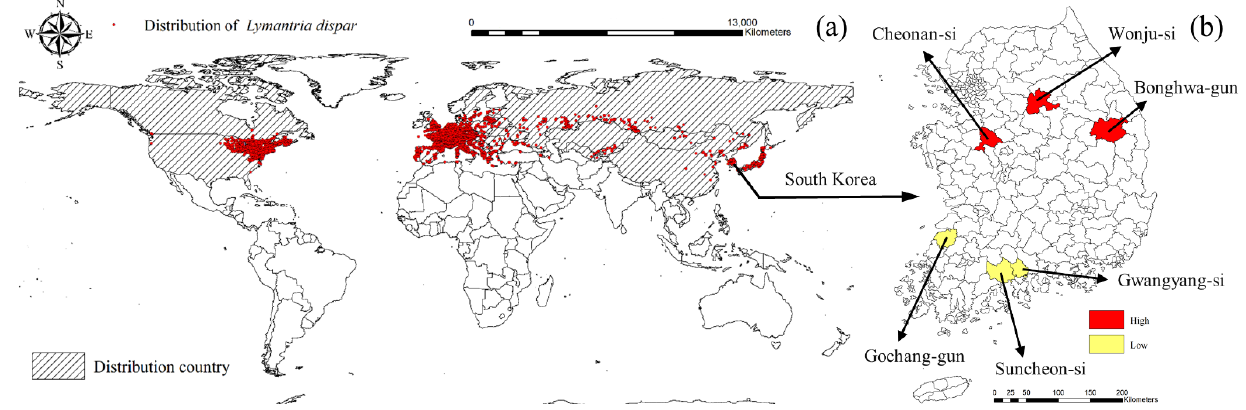
Figure 1. Distribution areas for spongy moths with ( a ) global occurrence coordinates with actual distribution sites (red dots), and ( b ) field survey areas with high and low spongy moth density applied for climatic analysis.